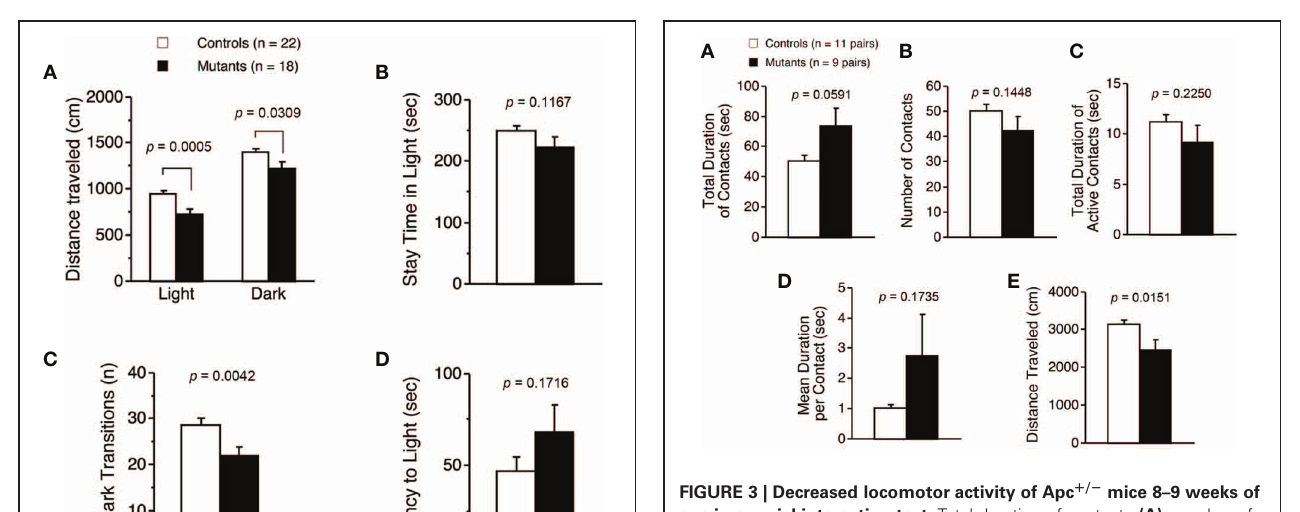
FIGURE 3 | Decreased locomotor activity of Apc + / − mice 8–9 weeks of age in a social interaction test. Total duration of contacts (A) , number of contacts (B) , total duration of active contacts (C) , mean duration per contact (D) , and distance traveled (E) were analyzed. Statistical difference between genotypes was not found in total duration of contacts, number of contacts, total duration of active contacts, or mean duration of per contacts. Distance traveled of Apc + / − mice was significantly decreased compared to wild-type mice. Apc + / − mice, n = 9 pairs; wild-type mice, n = 11 pairs. difference between genotypes was detected in the total dura- tion of contacts ( p = 0 . 0591; Figure 3A ), number of contacts ( p = 0 . 1448; Figure 3B ), total duration of active contacts ( p = 0 . 2250; Figure 3C ), and mean duration per contact ( p = 0 . 1735; Figure 3D ), while distance traveled of Apc + / − mice was sig- nificantly decreased compared to wild-type mice ( p = 0 . 0151; Figure 3E ). Taken together, these data suggest that locomotor activity was decreased in Apc + / −